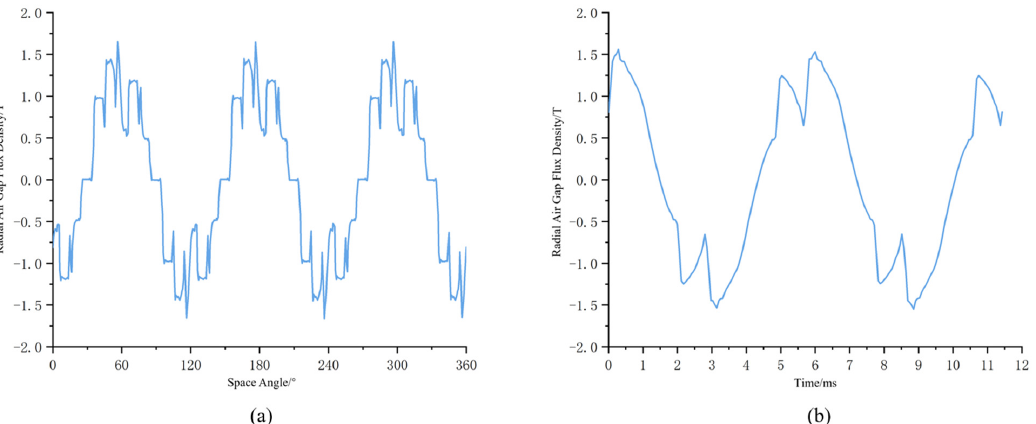
Figure 2. Air − gap flux density change: ( a ) 0.01 s changes with space angle; ( b ) change in time at a point on the stator tooth end.